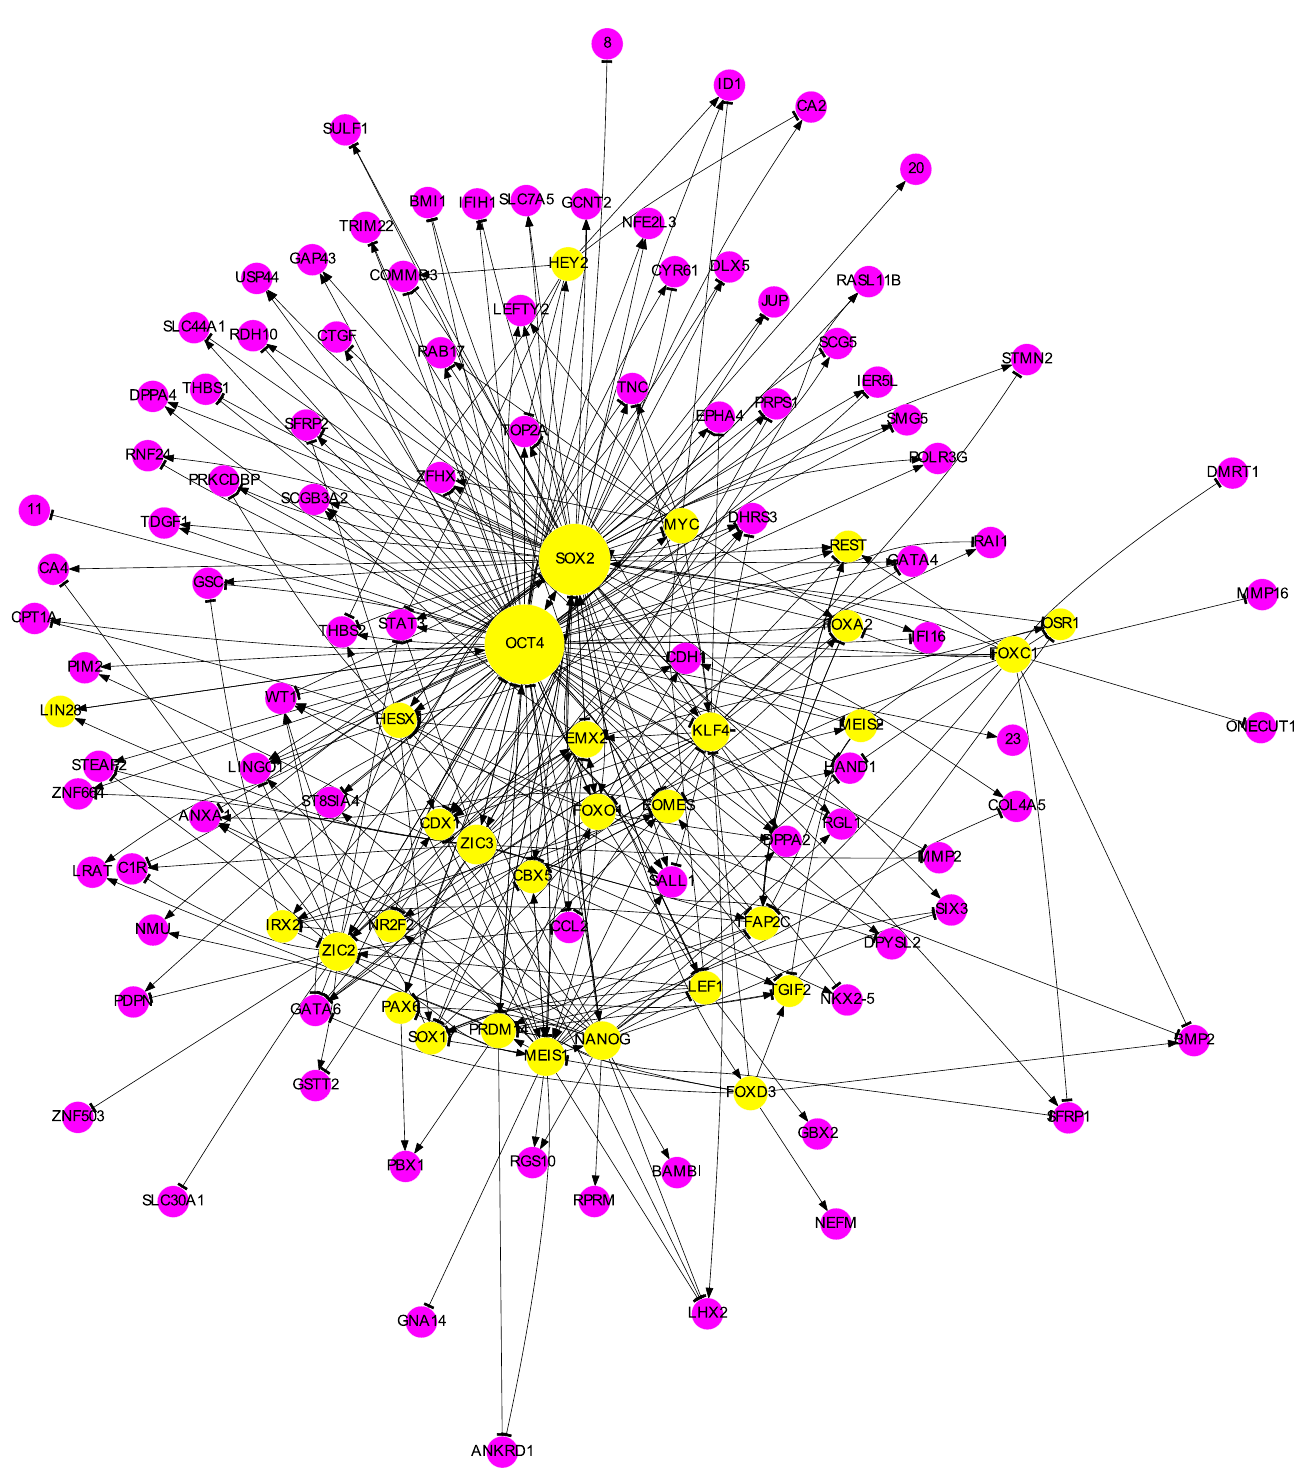
Fig 4. The SUBN1 network. The regulating nodes are shown as yellow circles whose radii increase linearly with the number of outgoing links. In magenta are the nodes that, in this subnetwork, do not regulate other nodes. Each magenta node that has only a numeric label k represents a collection of k nodes regulated in the same way. A “tee” arrowhead denotes downregulation, while a “normal” one indicates upregulation. If two nodes mutually regulate each other, only one link is shown with an arrowhead at each end.